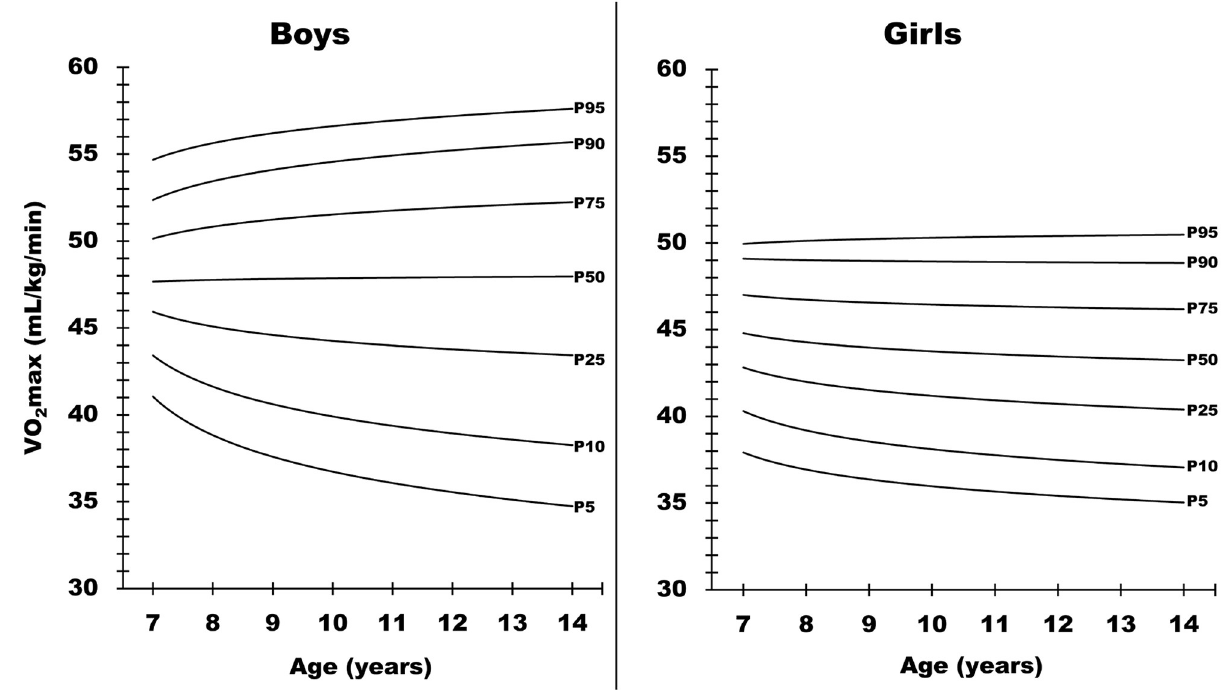
Fig 2. Graphical normative reference data for the VO 2 max (ml/kg/min) derived from the equation, according to sex and age.